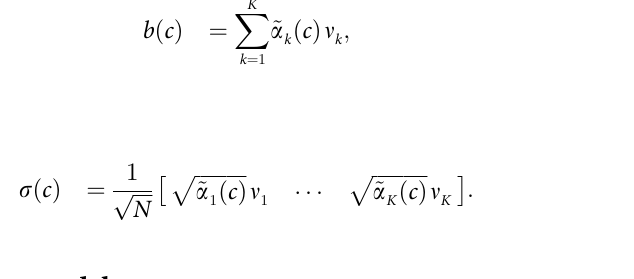
¼ 0 : 01 for i , ij